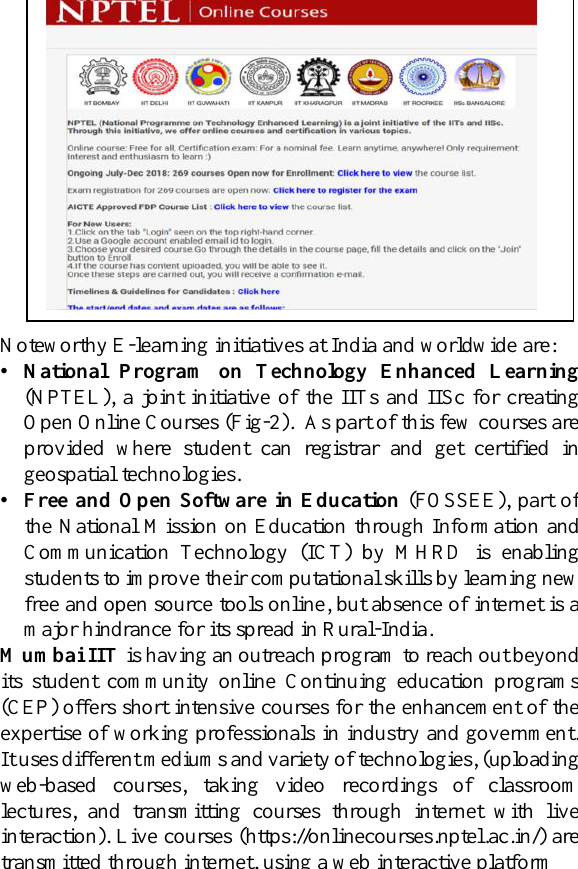
Fig-2: NPTEL portal for